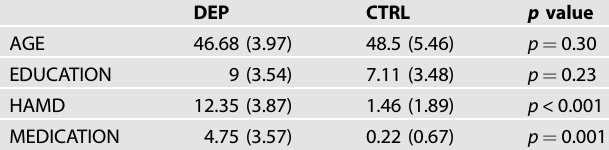
Table 1. Patients ’ demographic